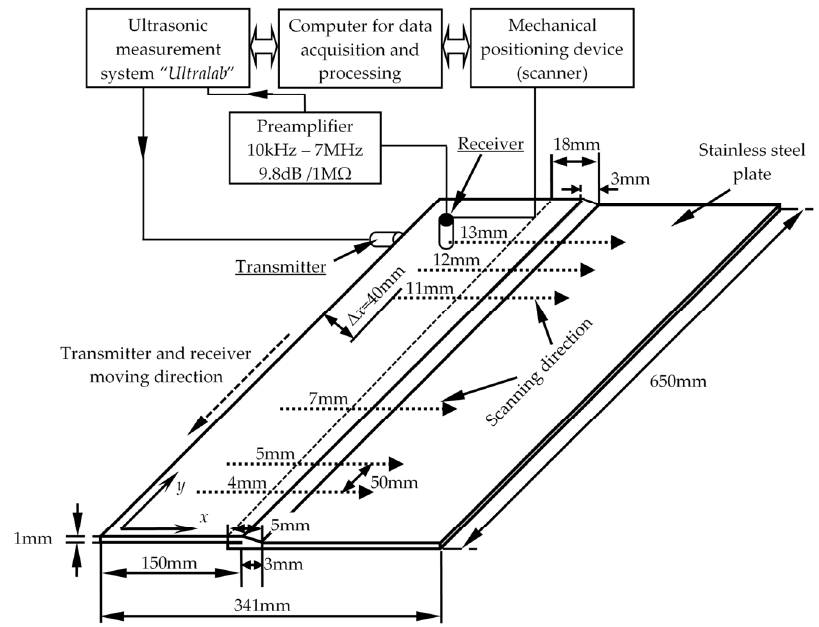
Figure 9. Experimental set-up for the investigation of the ultrasonic S 0 guided wave mode propagation through the lap joint welded plates with different overlap zone width ∆ l .